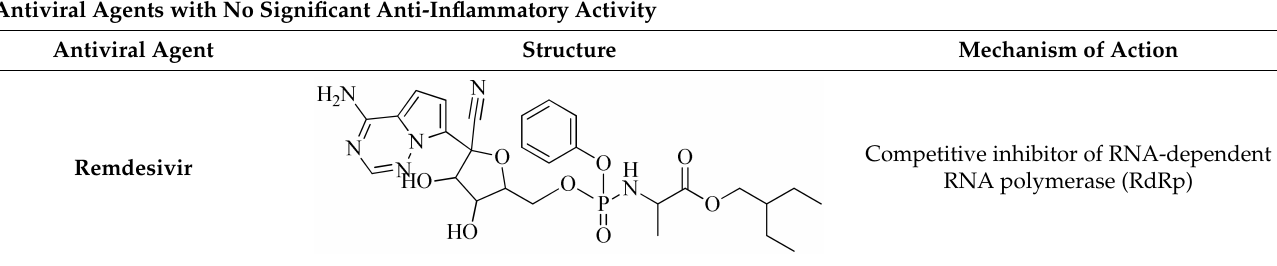
Table 1. Mechanisms of action of antiviral